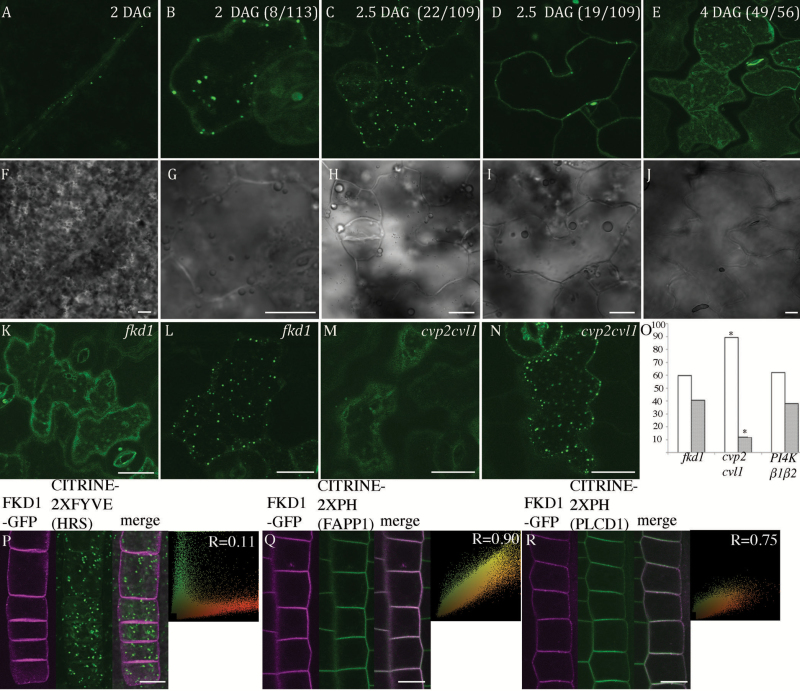
35S:FKD1–GFP localization is developmentally regulated and correlated with the phosphoinositide profile. 35S:FKD1–GFP localization in 2 DAG vascular cells (A) and in epidermal pavement cells at sequential days of cotyledon development (B, 2 DAG; C and D, 2.5 DAG; and E, 4 DAG). Corresponding bright field images are shown below (F–I). Comparison of 35S:FKD1–GFP localization in cotyledon pavement cells of fkd1 and cvp2cvl1 mutant plants. Localization in the cytosol and punctae in fkd1 (K and L, respectively) and in cvp2cvl1 mutant plants (M and N, respectively). (O) Graph representing the percentage of cotyledon pavement cells with 35S:FKD1–GFP localization in the cytosol (open bars) and punctae (gray bars) in fkd1 (n=30), cvp2cvl1 (n=33) and PI4Kβ1β2 (n=15) mutants. An asterisk indicates significantly different from the wild type (Fisher’s test, P<0.05). Co-localization of 35S:FKD1–GFP with markers for the phosphoinosities PtdIns(3)P (P), PtdIns(4)P (Q), and PI4,5P (R) in root epidermal cells. Within (P), (Q), and (R), sections are as labeled [FKD1–GFP alone, PtdIns(3)P marker UBQ10:CITRINE–2×FYVE(HRS), PtdIns(4)P marker UBQ10:CITRINE–2×PH(FAPP1), or PtdIns(4,5)P2 marker UBQ10:CITRINE–2×PH(PLCD1), the merged images, and the scatter plots of the corresponding merged image with Pearson’s coefficient of correlation (R) values]. Scale bar=10 μm).